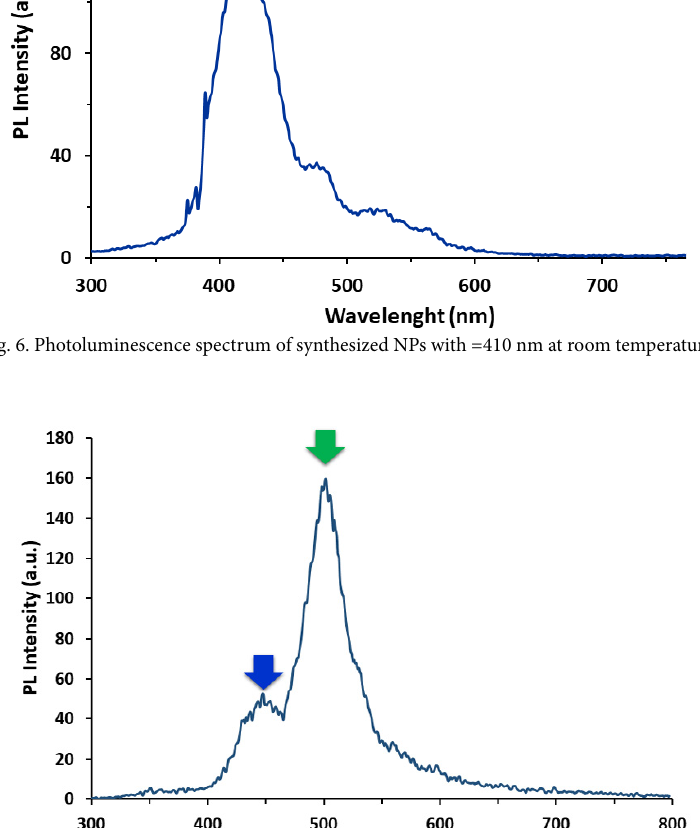
Fig. 7. Photoluminescence spectrum of synthesized NPs with =250 nm at room Figure 7. Photoluminescence spectrum of synthesized NPs with